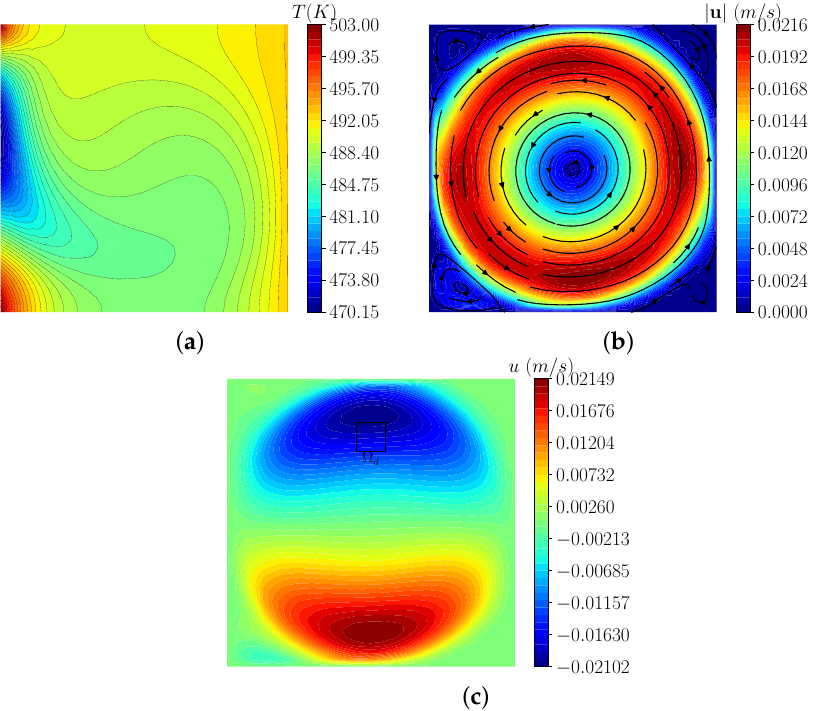
Figure 7. Velocity matching case with Dirichlet boundary control—Case 2: optimal solution for λ = 10 − 11 . Contours of the temperature field T ( a ); contours and streamlines of the velocity field u ( b ); contours of the x -component of the velocity field u ( c ). The velocity magnitude is indicated by u , and Ω d is the region where the objective is set. | |